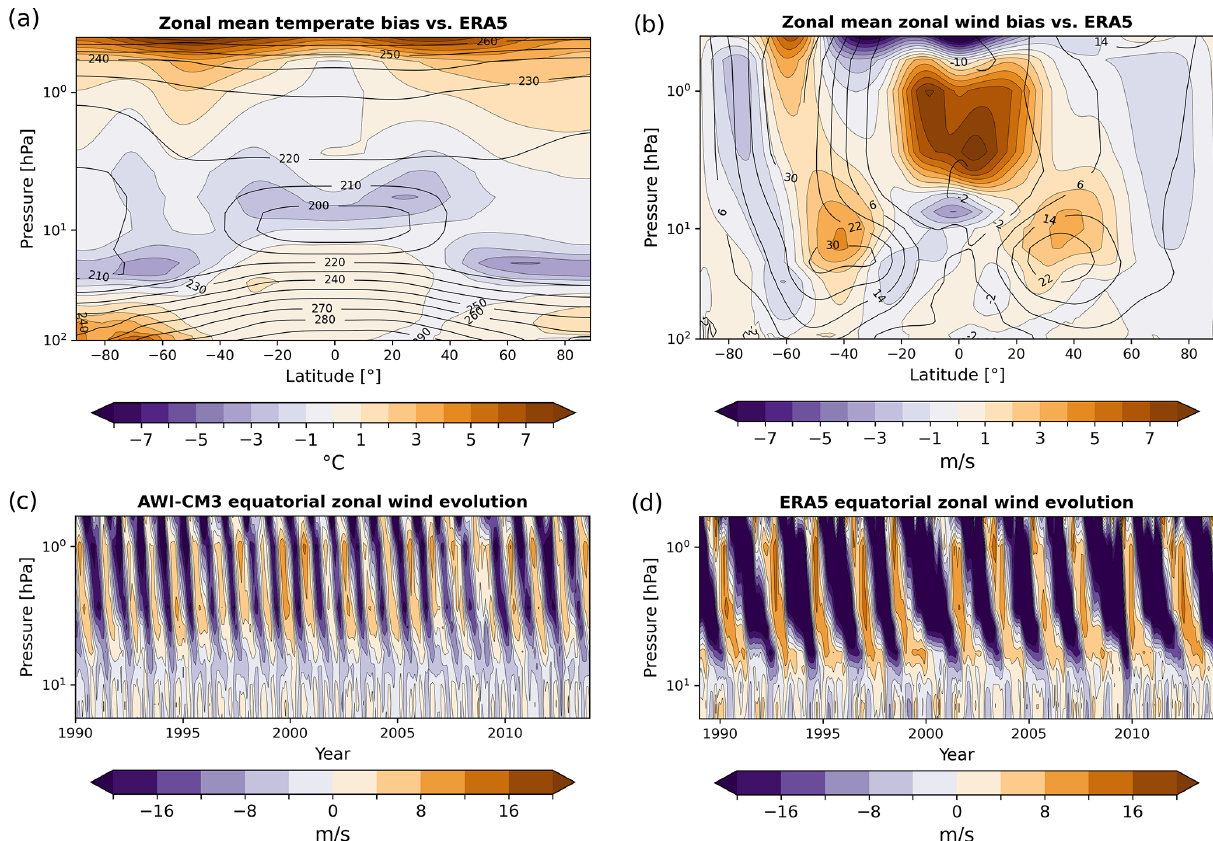
Figure 7. AWI-CM3 HIST (a) zonal-mean air temperature bias with respect to ERA5 averaged over the last 25 years; (b) zonal-mean zonal- wind bias with respect to ERA5 averaged over the last 25 years; (c) near-Equator zonal wind over time and height for AWI-CM3 HIST simulation; and (d) same as (c) but for ERA5 reanalysis, showing the Quasi-Biennial